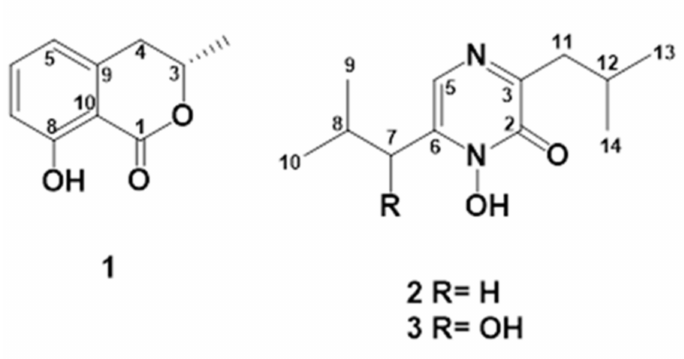
Figure 2. Chemical structures of compounds 1 – 3 .